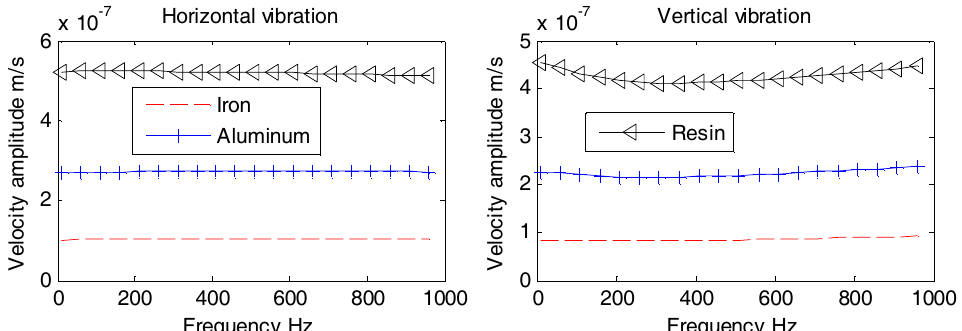
Figure 14. Vibration velocity amplitudes of the OBSs with different densities under incident angle of 60°.